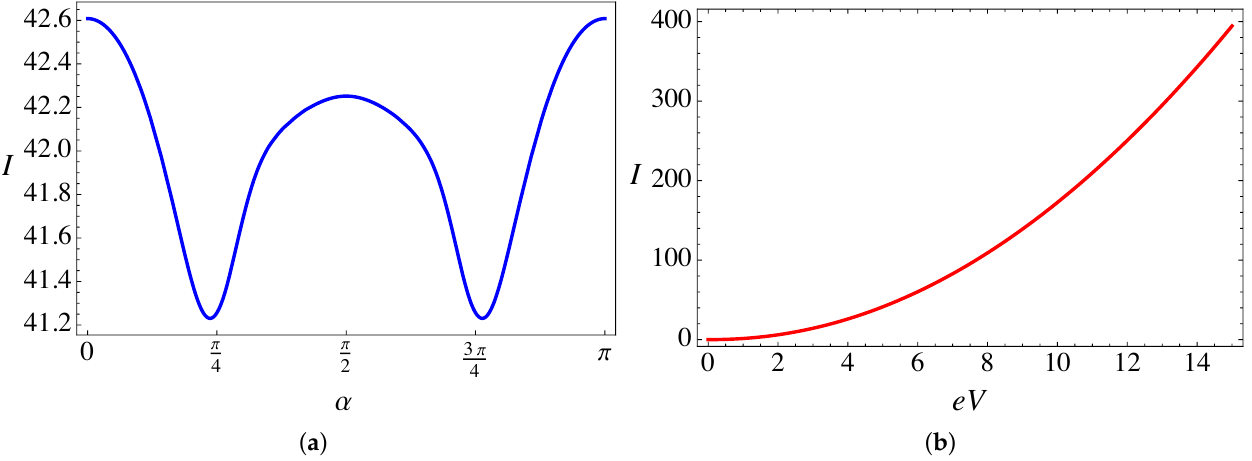
Figure 4. (Color online) Electric current (in units of ev F / a ) computed from the analytical expression in Equation (7) for the case of the RDSP barrier alone and T = 0.2 ¯ hv F / k B a : ( a ) Plotted as a function of the applied bias eV (in units of ¯ hv F / a ) and ( b ) plotted as a function of α